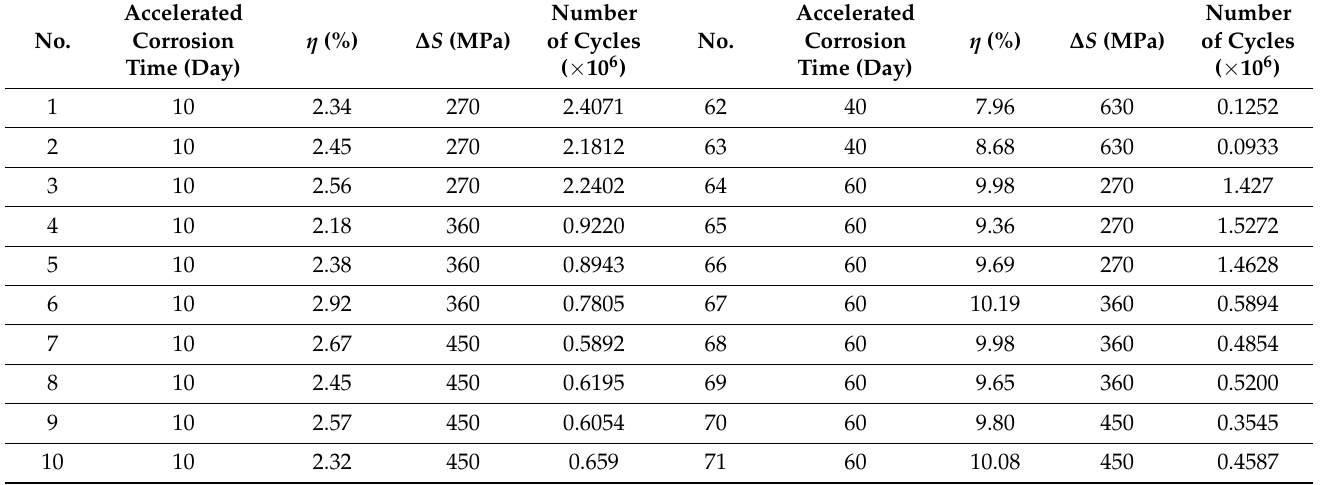
Table A1. Test data of steel